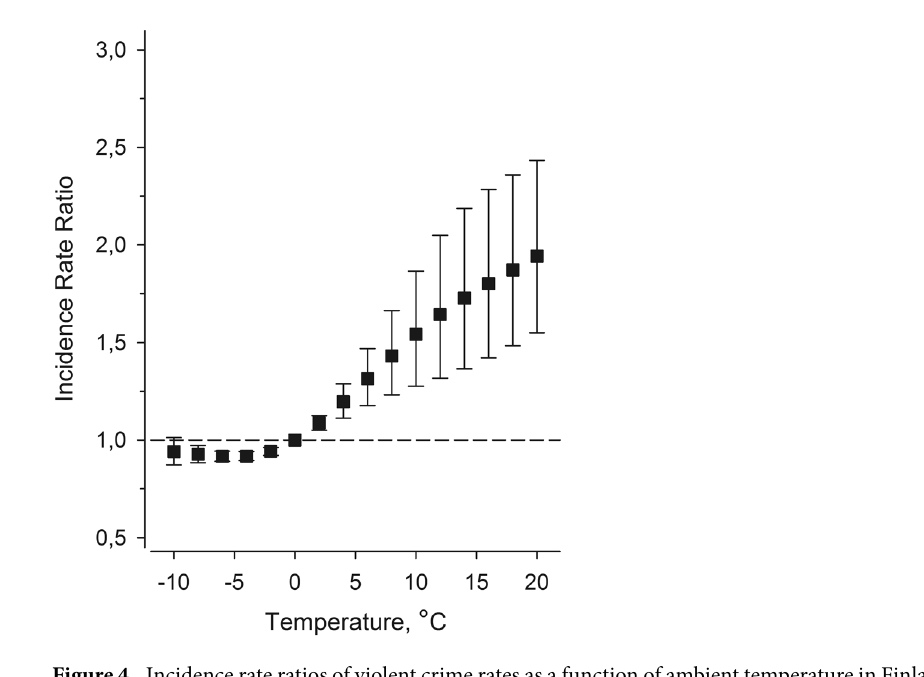
Figure 4. Incidence rate ratios of violent crime rates as a function of ambient temperature in Finland. Data were fitted by using a Poisson regression model with restricted cubic splines of 5 knots. The reference value of temperature is 0 °C. The increase per degree centigrade is 1.7% (95% CI 1.1 to